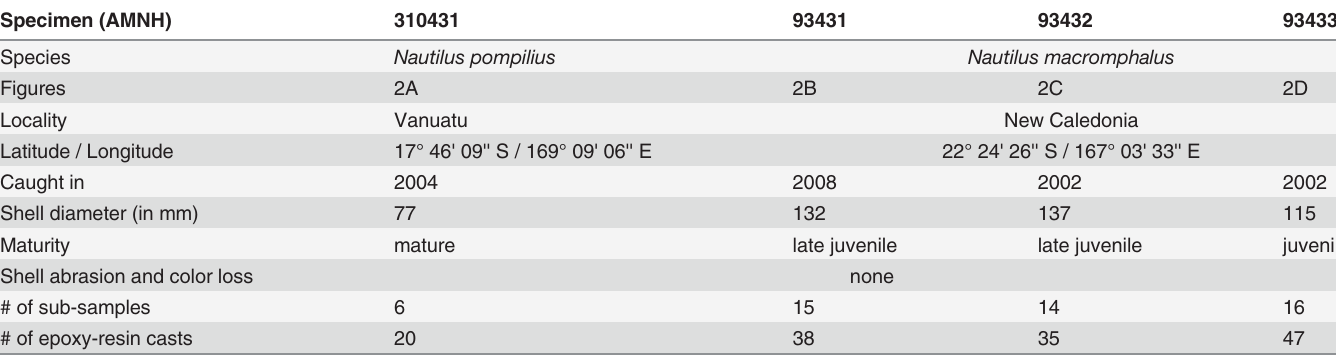
Table 1. Sample specifications of the four studied Nautilus